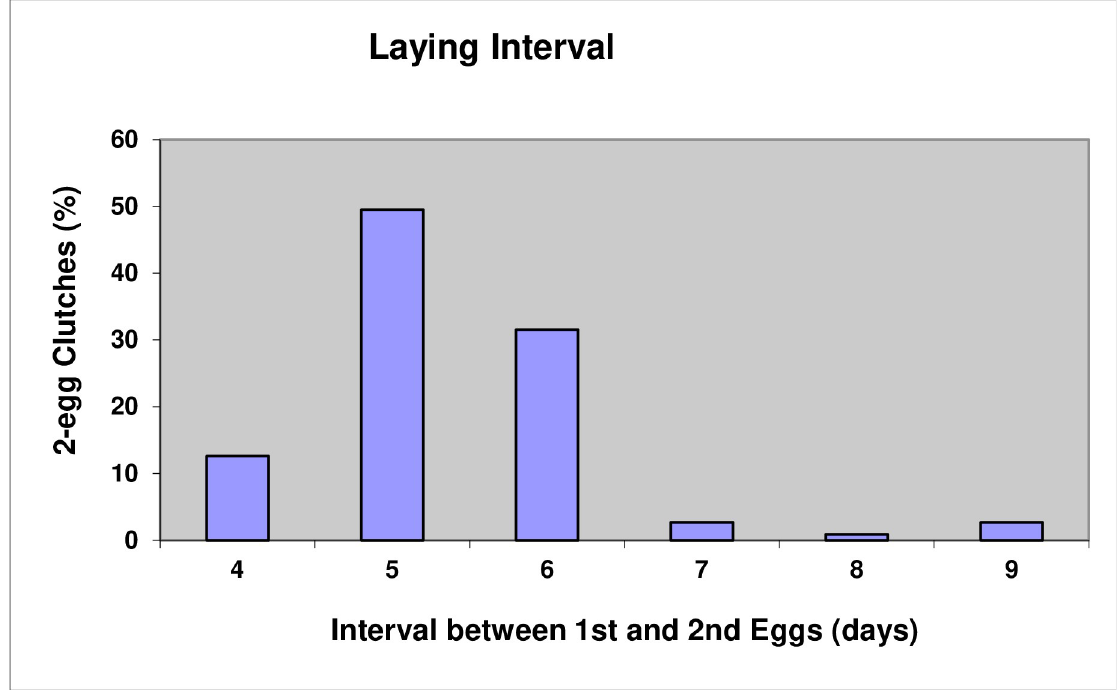
Fig 2. Laying intervals for two-egg clutches of erect-crested penguins (n =